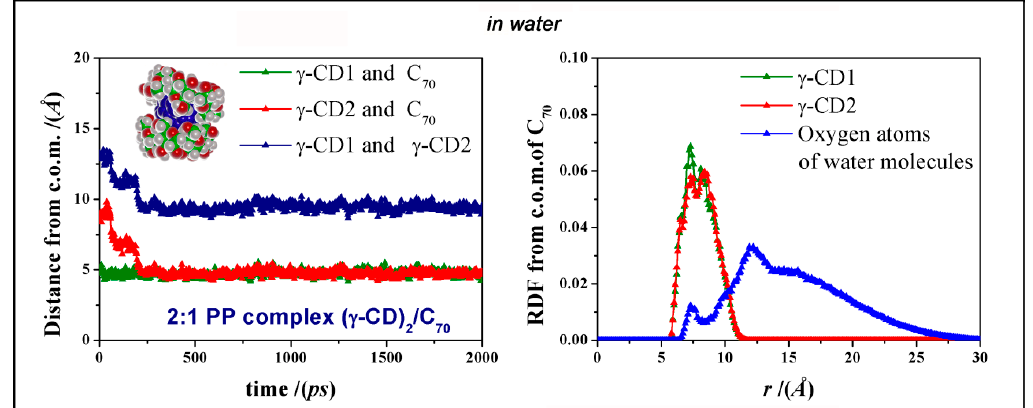
Figure 6. At left, the distance calculated during MD run in water between the c.o.m. of C 70 and of the first γ -CD (the lower CD in the inset) in green, between the c.o.m. of C 70 and of the second γ -CD (the upper CD) in red, and the distance between the c.o.m. of the two γ -CDs in blue for the PP complex. At right, the radial distribution function RDF calculated as a function of the distance r from the fullerene c.o.m of the atoms of two di ff erent γ -CDs of the PP [( γ -CD) 2 / C 70 ] complex and of oxygen atoms of the water molecules.